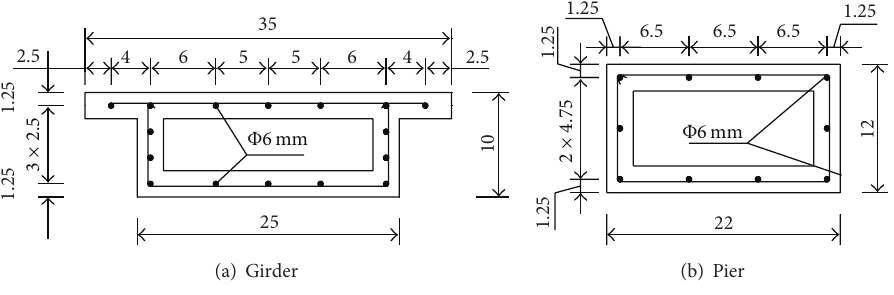
Figure 3: Design of model (unit: cm).